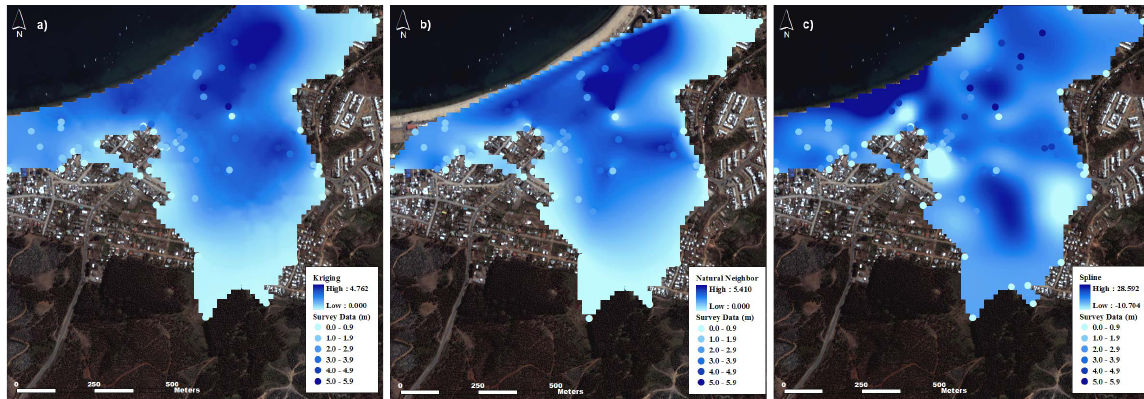
Fig. 6. Three interpolation methods for the point survey data were used. (a) Kriging method; (b) Natural Neighbor method; (c) Spline method.